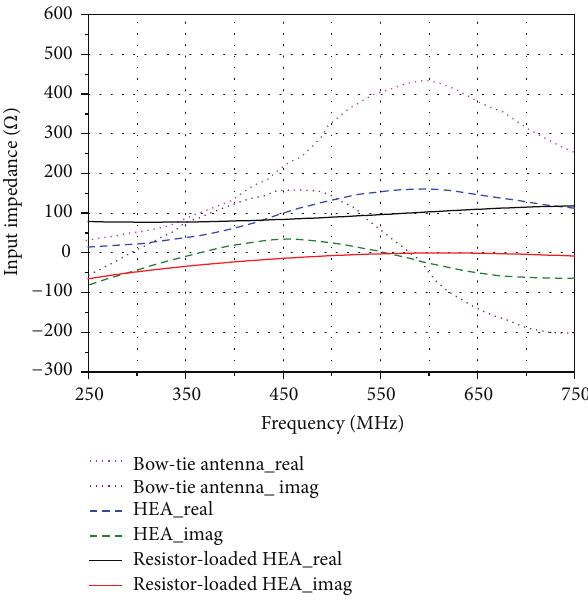
Figure 2: Comparison of the input impedance.